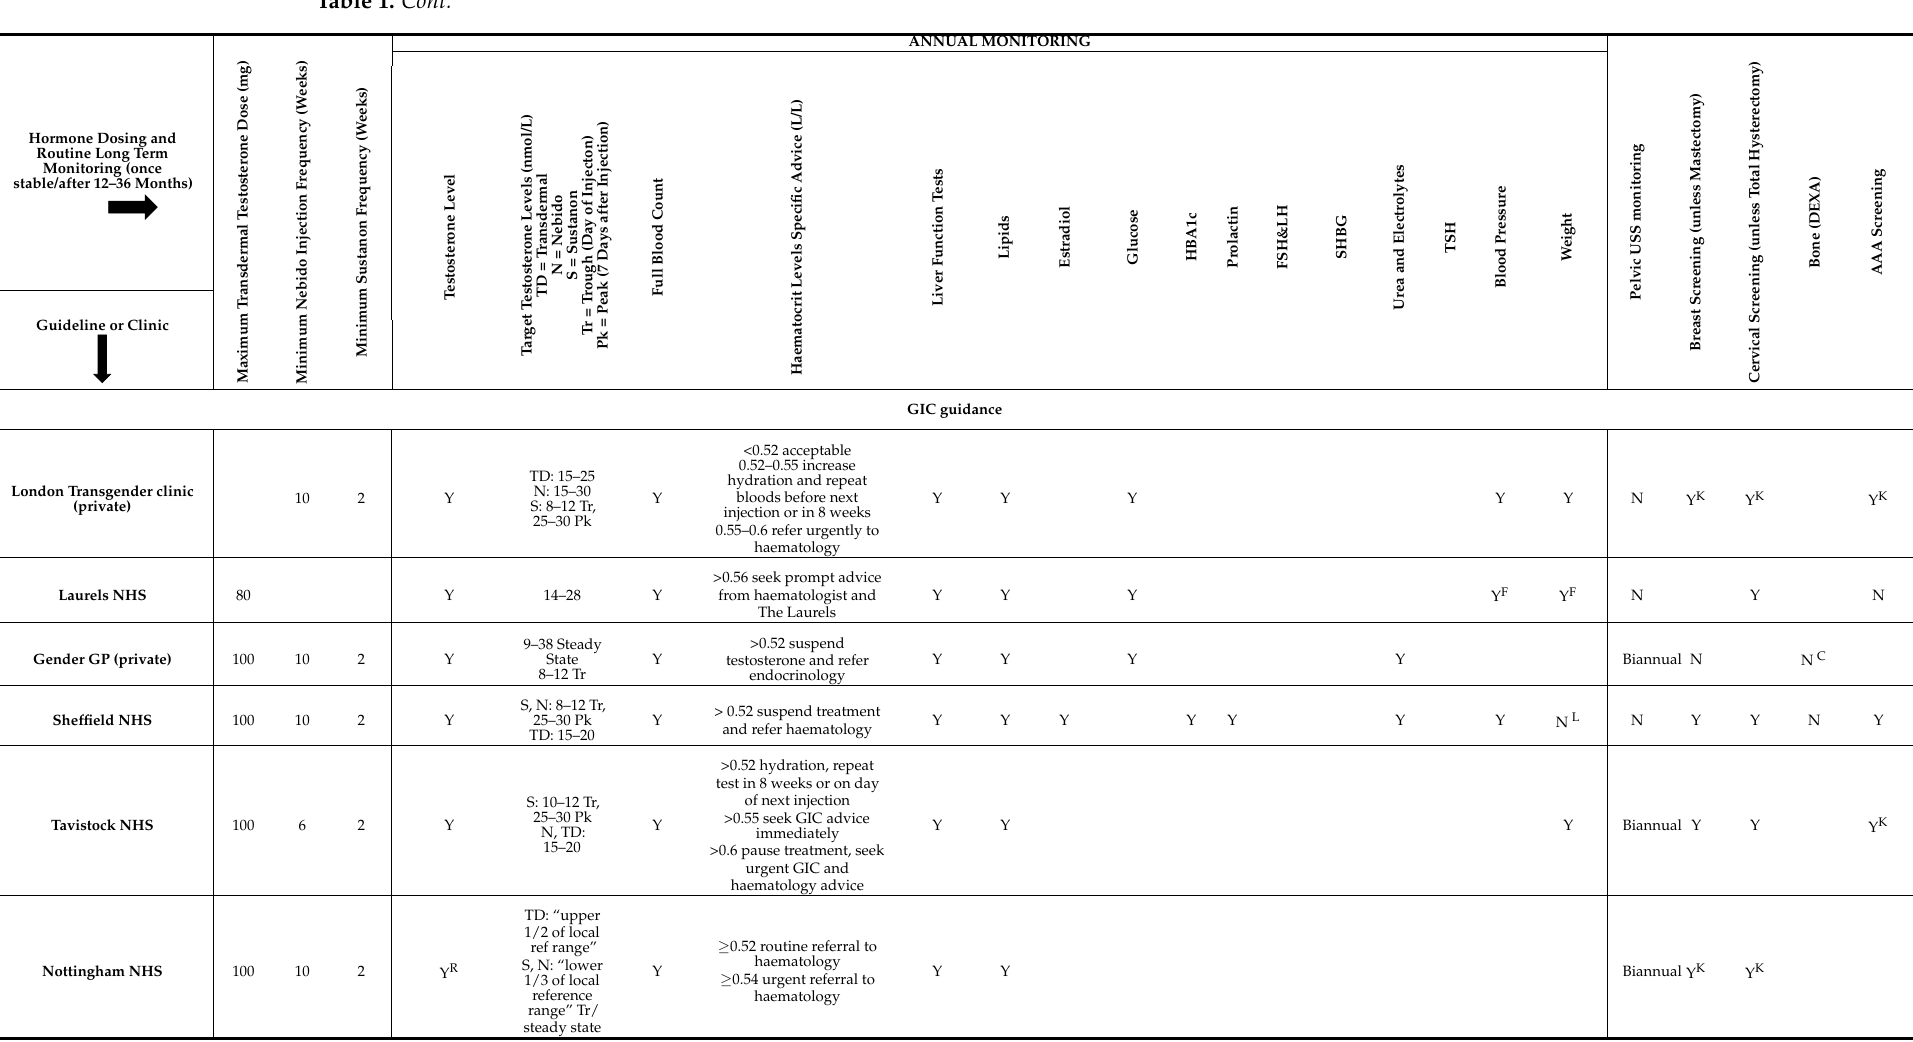
Table 2. Comparison of national, international, and patient specific prescribing and monitoring guidelines for trans women (observed males at birth) with gender dysphoria.